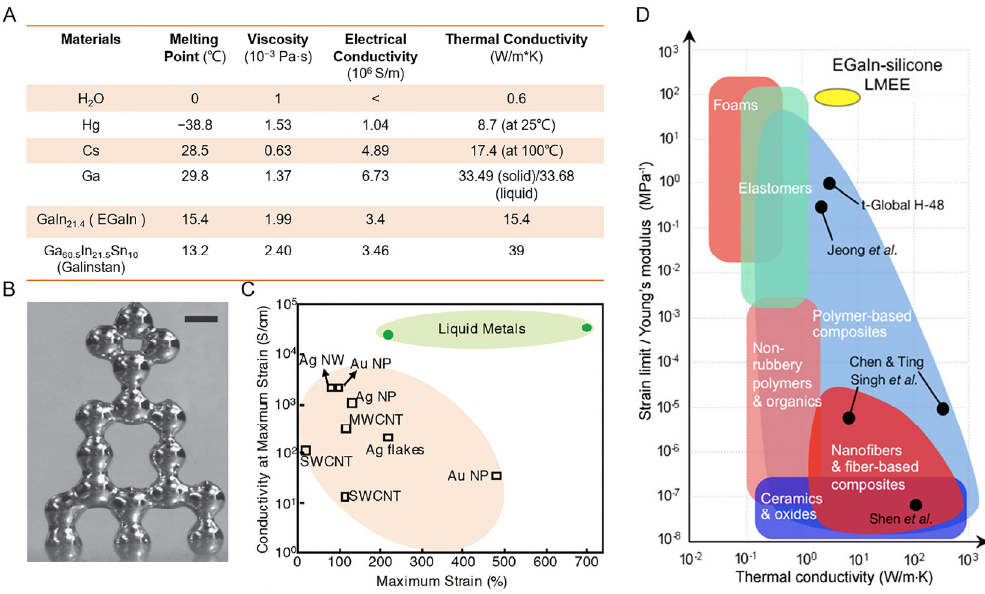
Figure 2. The fundamental physical properties of LMs. ( A ) Physical properties of water and typical metals. Data from Tang et al. [25], Chen et al. [26], Zhu et al. [27] and Chen et al. [28]. ( B ) A freestanding 3D tower of liquid metal droplets [29]. Copyright: (2013) WILEY-VCH. ( C ) Comparison of the maximum strain conductivities of different flexible conductors [36]. Copyright: (2018) WILEY- VCH. ( D ) Summary of the thermal conductivity for various materials as a function of the strain limit to Young’s modulus ratio [37]. Copyright: (2017) National Academy of Sciences.